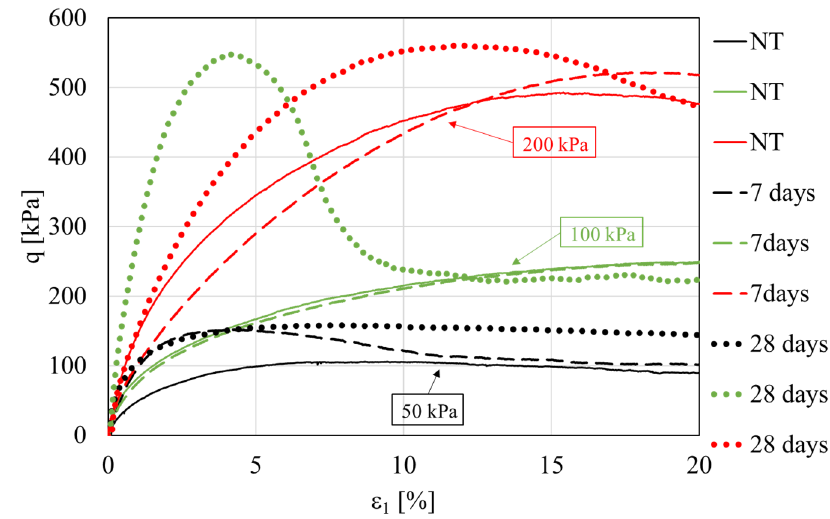
Figure 9. Triaxial for Maicillo treated with CMICP.